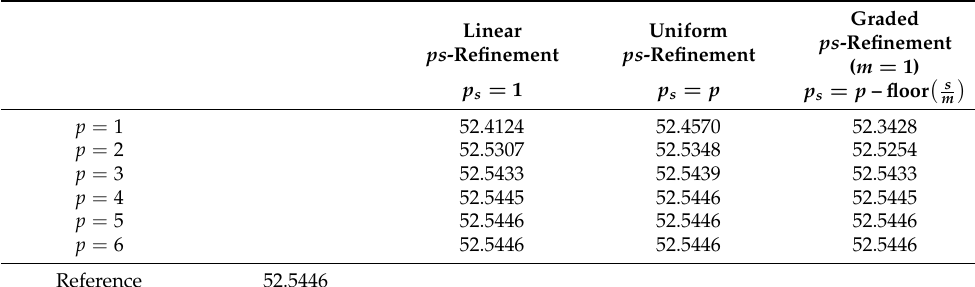
Table 4. Convergence of nondimensional energy for different ps − refinement strategies.